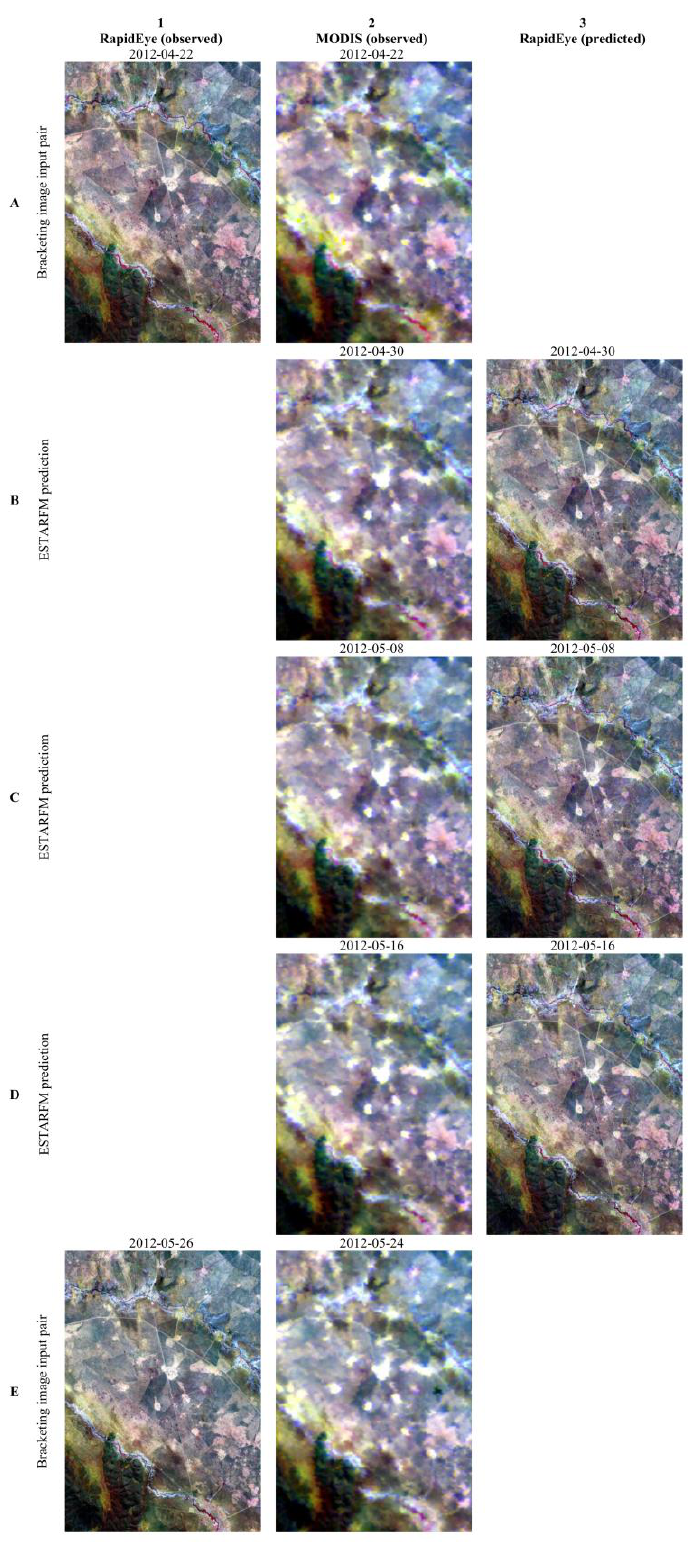
Figure 3. Exemplary comparison between observed RapidEye scenes ( left column ), observed MODIS scenes ( central column ), and ESTARFM predicted RapidEye scenes ( right column ) for Subset 2 for 3 acquisition dates in April and May 2012. First and last row (A,E) show images used as bracketing pairs t 1 and t 2 . All images are shown as false-colour datasets